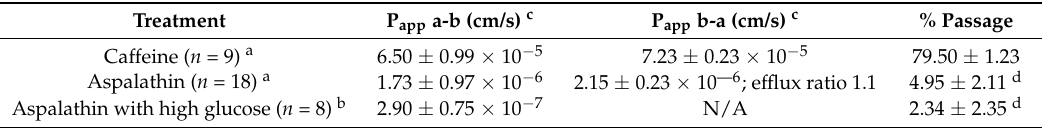
Table 2. Apparent permeability and % passage (calculated as a direct measure of concentration) of aspalathin (150 µ M) and caffeine (260 µ M) across the Caco-2 monolayer.